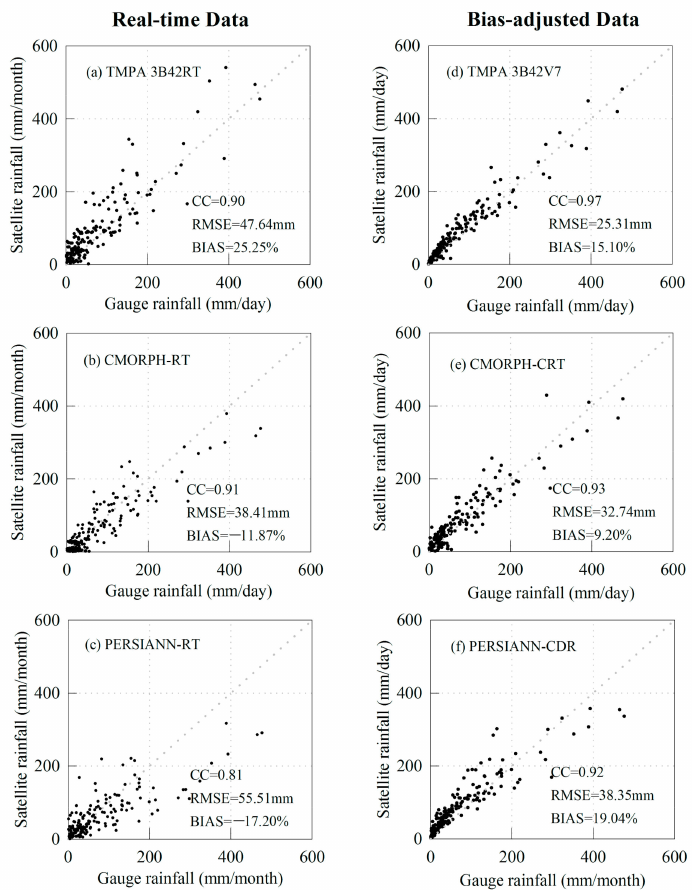
Figure 4. Scatterplots of the basin average monthly precipitation between SPPs and rain gauge observations for Xixian Basin: ( a ) TMPA 3B42RT; ( b ) CMORPH-RT; ( c ) PERSIANN-RT; ( d ) TMPA 3B42V7; ( e ) CMORPH-CRT; ( f )